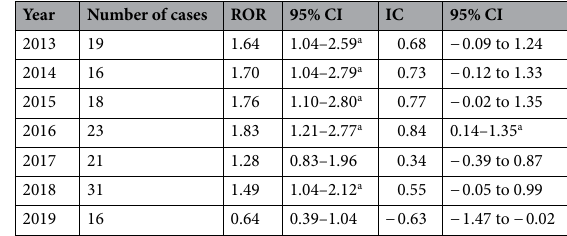
Table 4. Year-wise disproportionality analysis for pancreatitis associated with tocilizumab use. CI confidence interval, IC information component, ROR reporting odds ratio. a Statistically